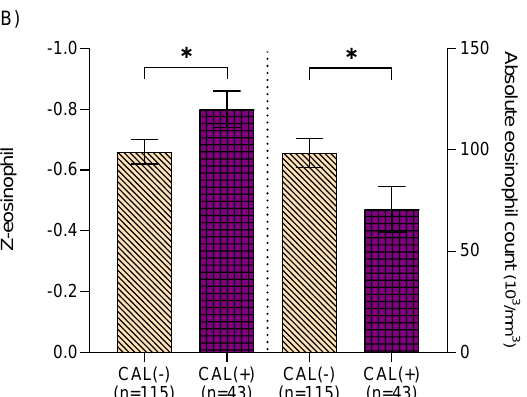
Figure 1. ( A ) Among Kawasaki disease patients with Z-eosinophil ≥ 0, coronary artery lesion (CAL) formation was found in those with higher absolute eosinophil counts (754.92 ± 62.25 cells/mm 3 , vs. 607.91 ± 31.48 cells/mm 3 , p < 0.05) and higher Z-eosinophil (3.04 ± 0.17 vs. 2.22 ± 0.19, p < 0.05). ( B ) Among Kawasaki disease patients with Z-eosinophil < 0, coronary artery lesion (CAL) formation was found in those with lower absolute eosinophil counts (70.59 ± 11.18 cells/mm 3 vs. 98.55 ± 7.15 cells/mm 3 , p < 0.05) and lower Z-eosinophil ( − 0.8 ± 0.06 vs. − 0.66 ± 0.04, p < 0.05). Asterisk (*) indicates a p value of < 0.05 between two groups.